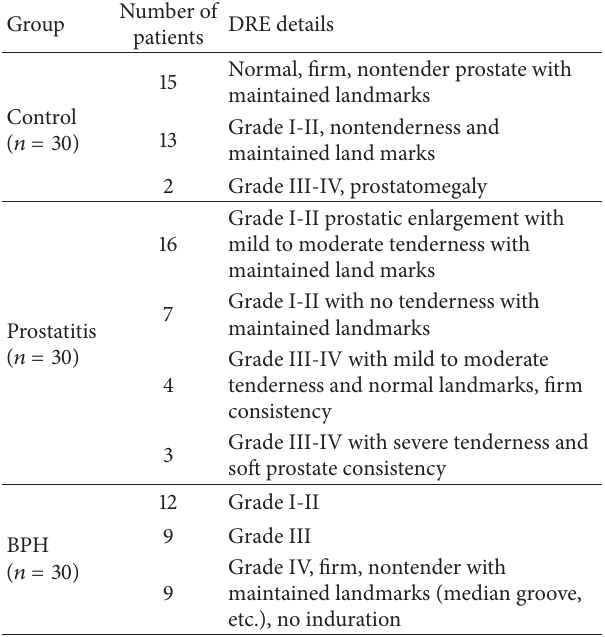
Table 4: The percentage of diagnostic efficiency (DE). Table 5: The analysis of prostate gland in patients of various groups based on digital rectal examination Control versus Prostatitis versus BPH versus Parameter total BPH P.Ca